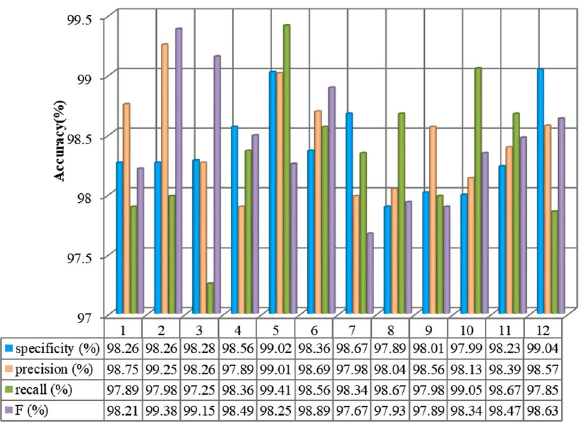
Figure 6. The experiment results of MKJDA (Task